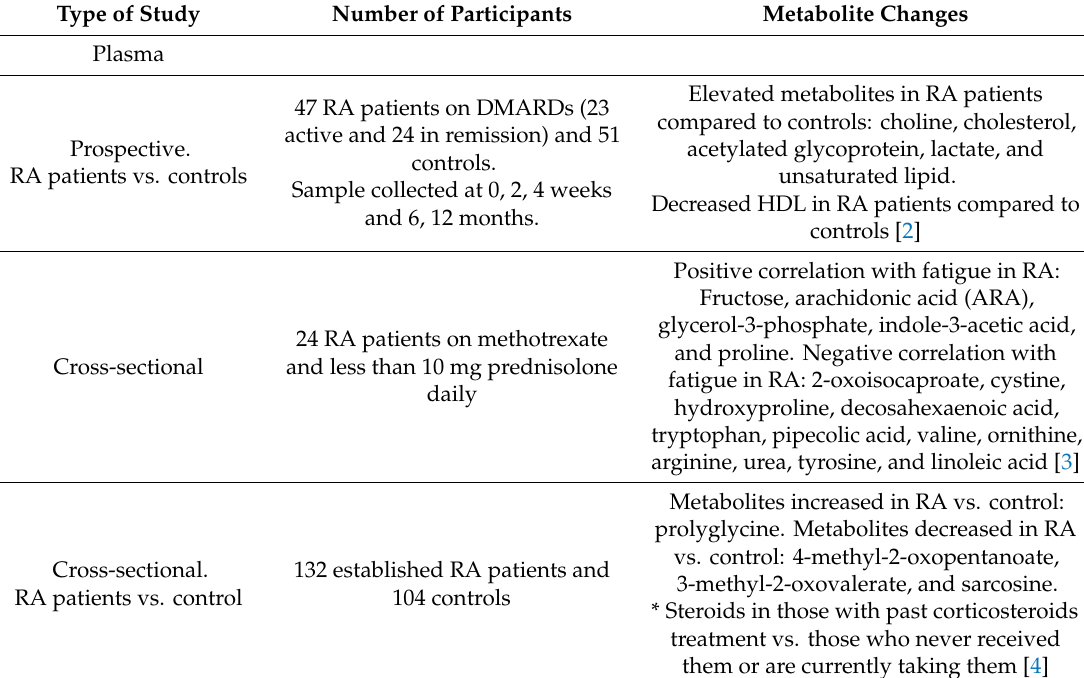
Figure 1. Pro- and anti-inflammatory circulating metabolites described in rheumatoid arthritis (RA) patients. The red color indicates pro- and the green indicates anti-inflammatory metabolites. The arrows indicate increases / decreased concentrations of the metabolites compared to healthy controls. Table 1. Metabolic profile changes in plasma or serum of patients diagnosed with rheumatoid arthritis (RA). DMARD: disease-modifying antirheumatic drugs; GC: glucocorticoids; pSS primary Sjogren syndrome.